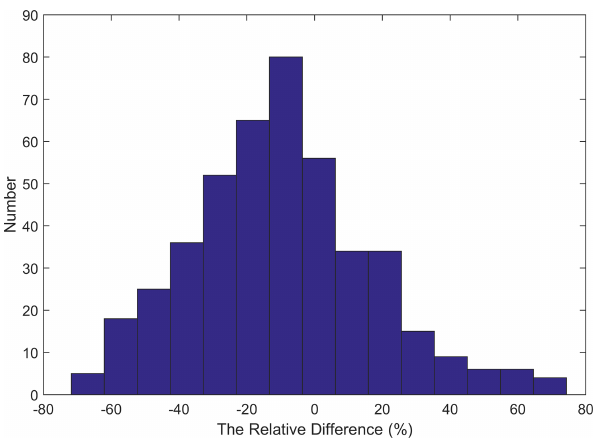
Figure 9. The relative difference distribution between IPM NmF 2 and IGGCAS ionosonde NmF 2 .